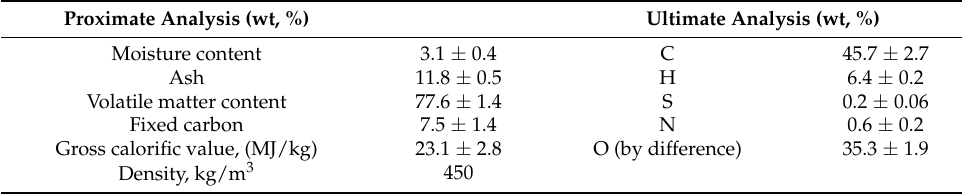
Table 1. Proximate and ultimate analysis of